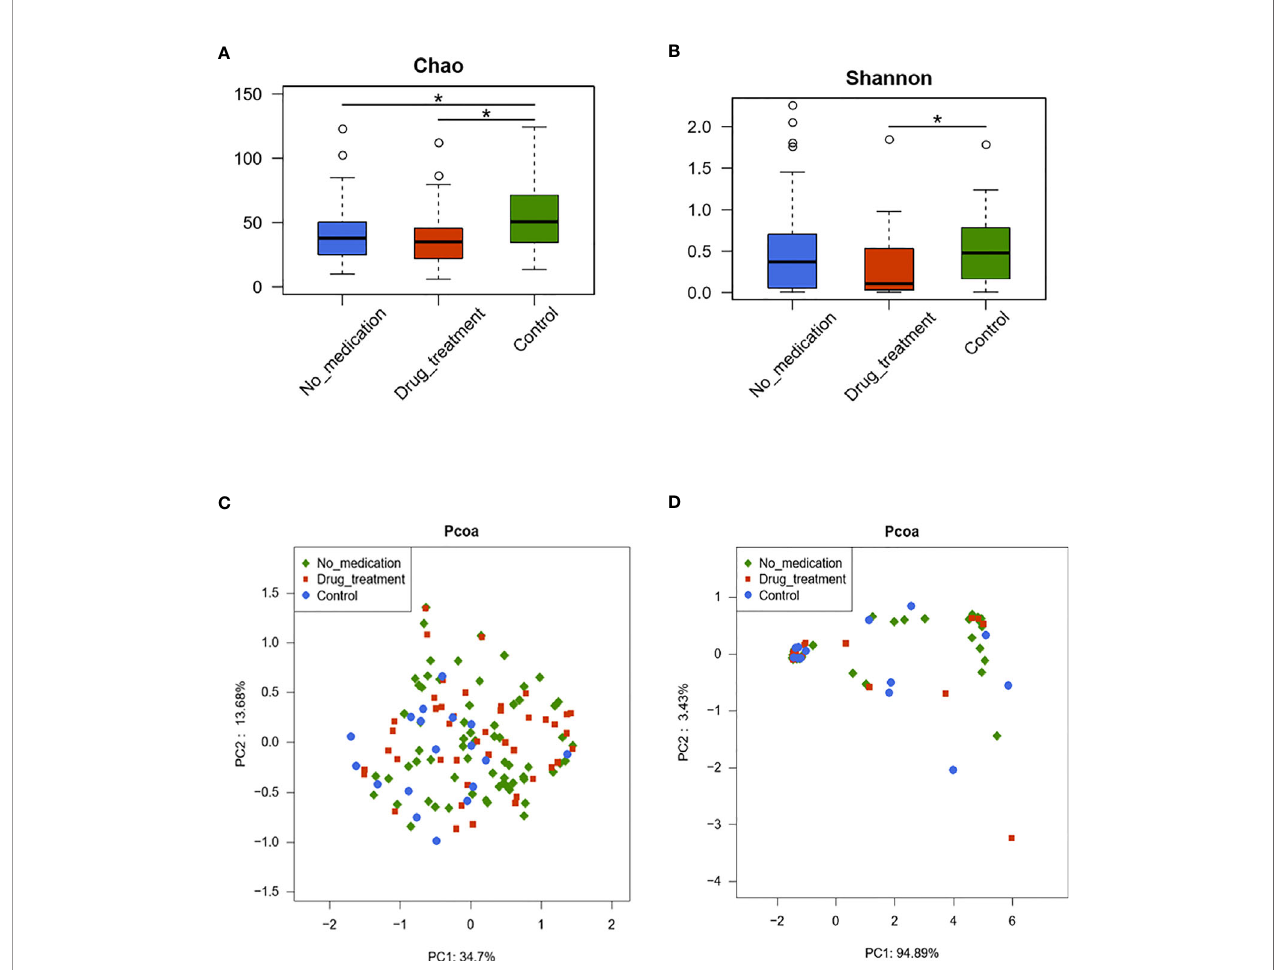
FIGURE 1 | The diversities of vaginal microbiota in the three groups are shown by the Chao index (A) , Shannon – Wiener index (B) , and principal coordinate analysis (PCoA) plot created based on the unweighted (C) and weighted (D) UniFrac distances. The values show the percentages of total community variation explained. (A, B) p -values were calculated using the one-sided Wilcoxon rank-sum tests. * p < 0.05.